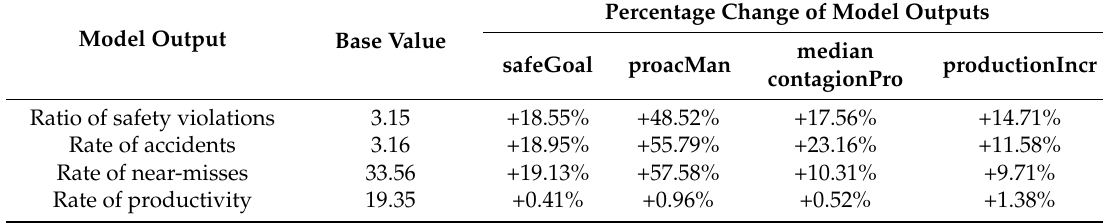
Table 3. Sensitivity analysis of the baseline